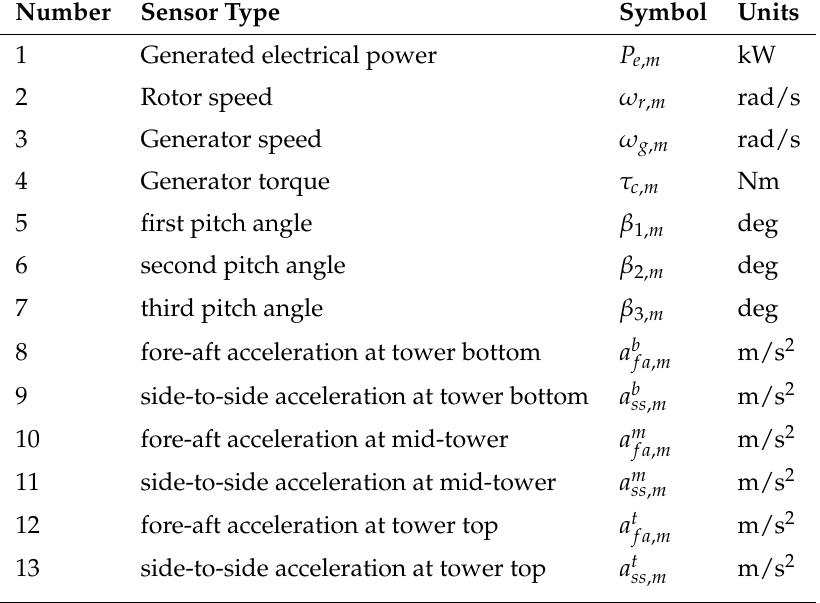
Table 4. Assumed available measurements. These sensors are representative of the types of sensors that are available on a MW-scale commercial wind